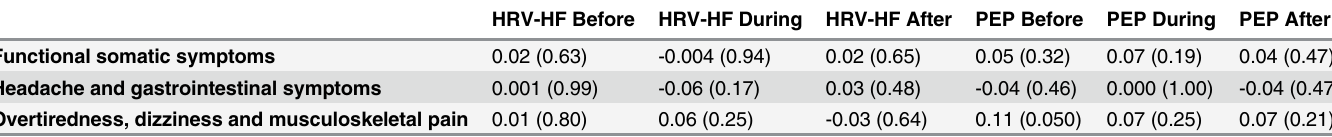
Table 3. The associations between ANS activity before, during and after the Groningen Social Stress Test (GSST) and FSS assessed in sitting